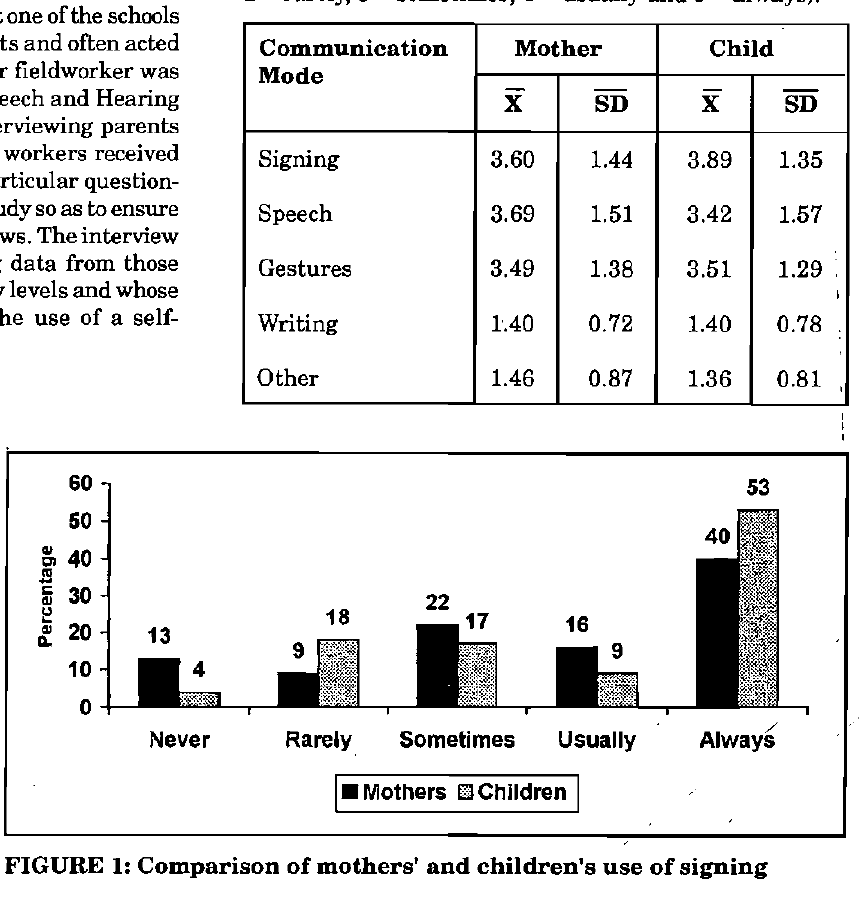
TABLE 1: Frequency of use of the various modes of communication used by mothers and their children